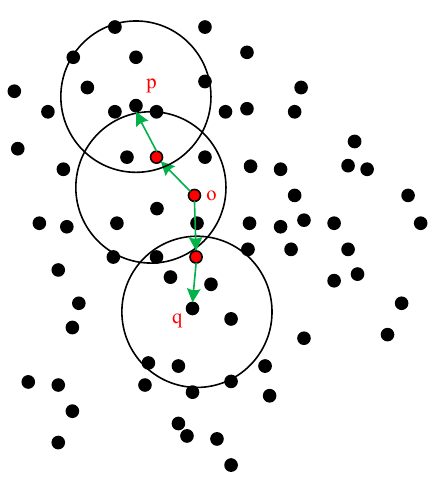
Figure 4. Definition of density-connected.